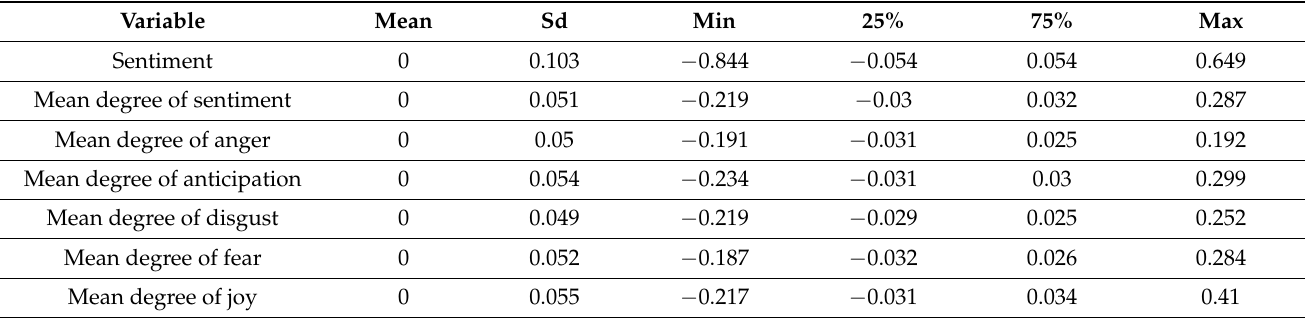
Table 1. Summary